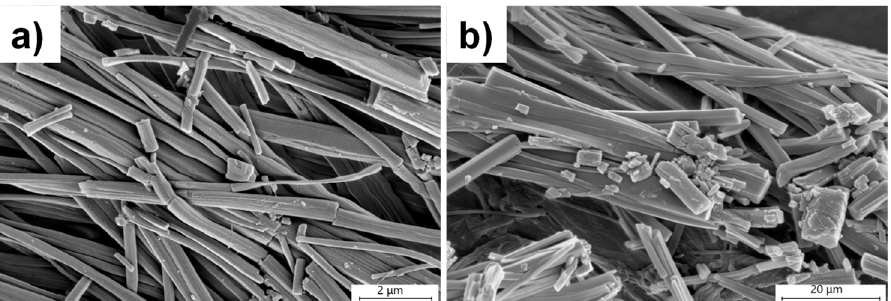
Figure 6. SEM images of xerogels obtained from pure water at 2.0 wt% in the presence of 1.0 equivalence of NaCl, ( a ) L 1 , and ( b ) L 3 .